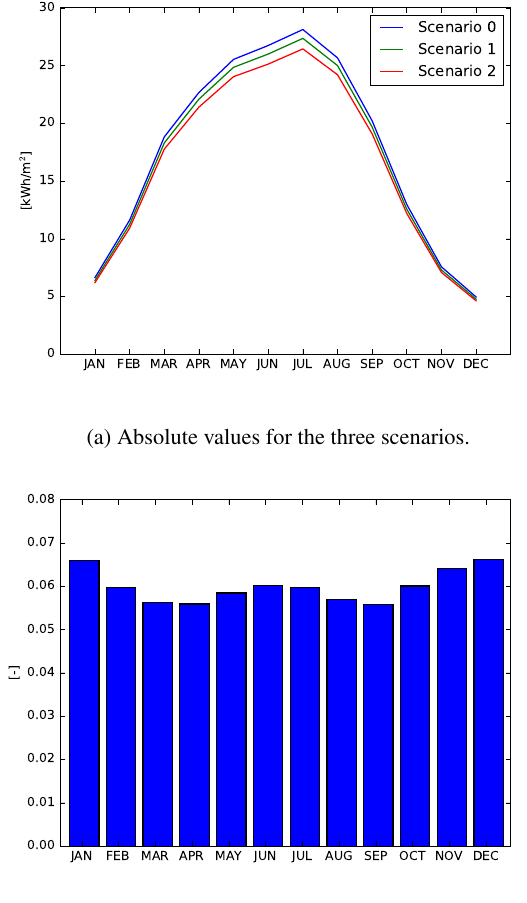
Figure 4. Monthly solar irradiation (tile